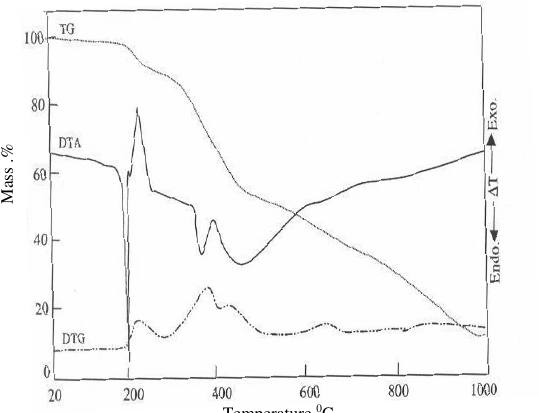
Figure 10. TG, DTG and DTA curves for [Cd (TEA)